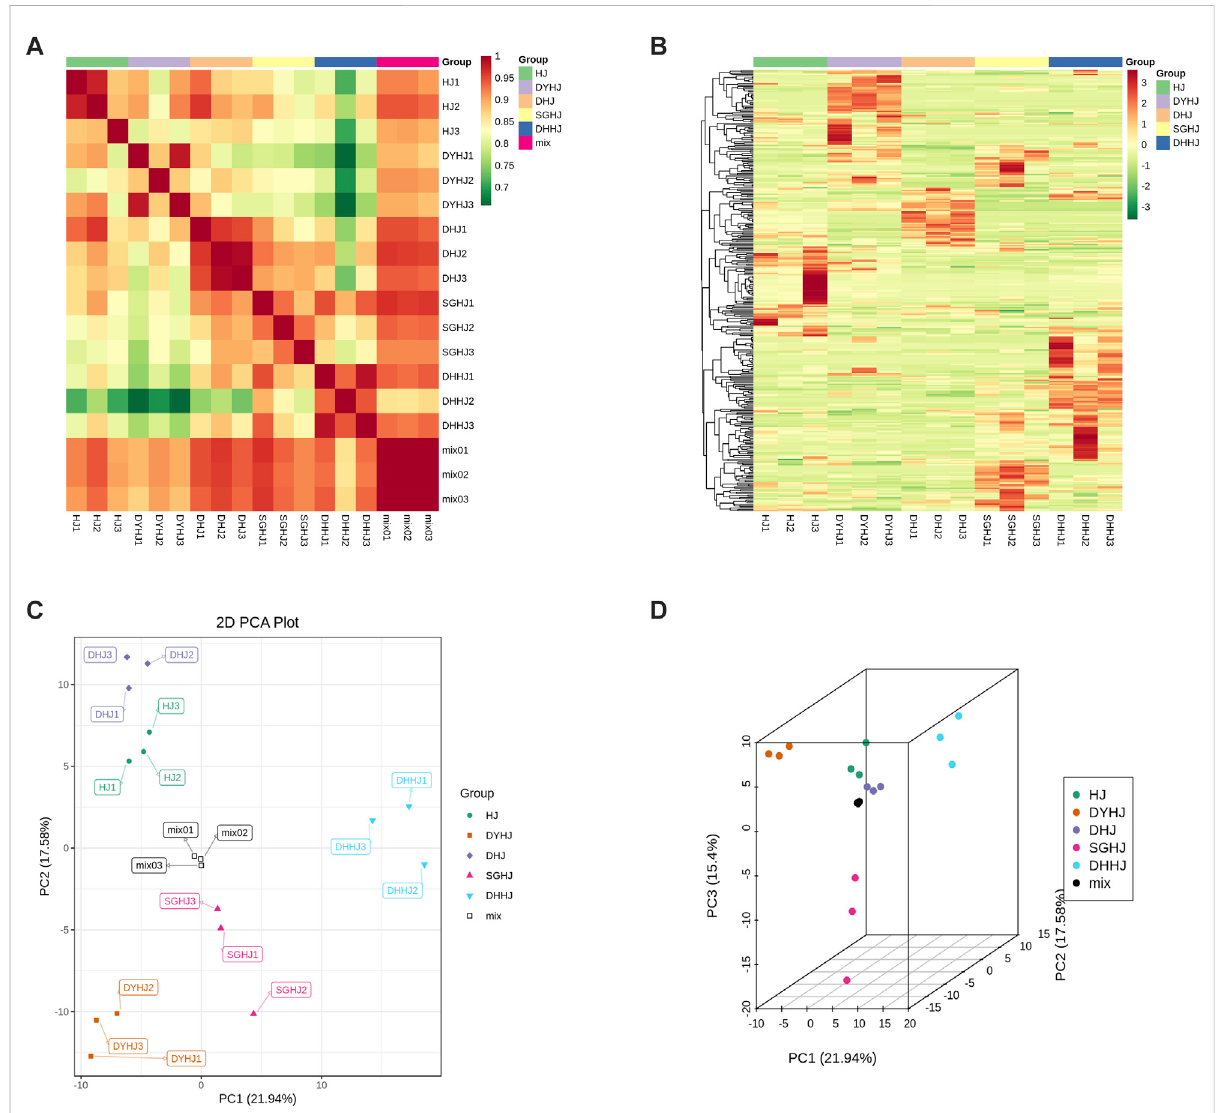
FIGURE 2 (A) Correlationofallthesamples.Thecorrelationanalysisbetweenthesampleswasusedtoestimatethebiologicalduplication amongsamples withinagroup.ThecloserR 2 isto1,thestrongerthecorrelationbetweenthetworepeatedsamples. (B) Clusteringheat-mapofmetabolitesofallthe samples. The upregulated and downregulated metabolites were expressed with different shade colors of red and green, respectively. With the increase in the abundance value, the color of the bar changed from green to red. When the abundance value was 0, the color of the bar was white,asshowninthebarattheupperright. (C) Differentialmetabolitesanalysisonthebasisofprincipalcomponentanalysis(PCA). (D)